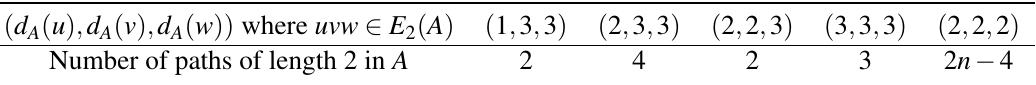
Table 5 Partition of paths of length 2 of the graph A = L ( S ( T n , k )) for k = 1